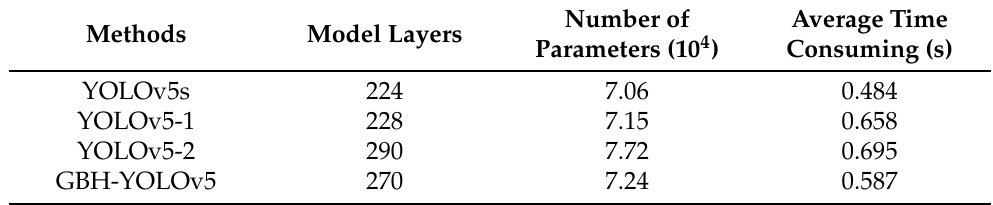
Table 6. The summary of the different models and the average elapsed time on the test